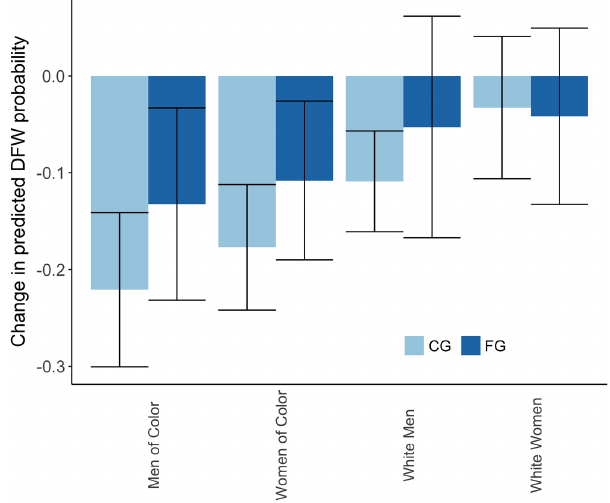
FIG. 3. Predicted DFW rate decreases for each demographic group in LA-supported courses versus traditional courses, ac- counting for instructor types. Error bars represent 95% confidence